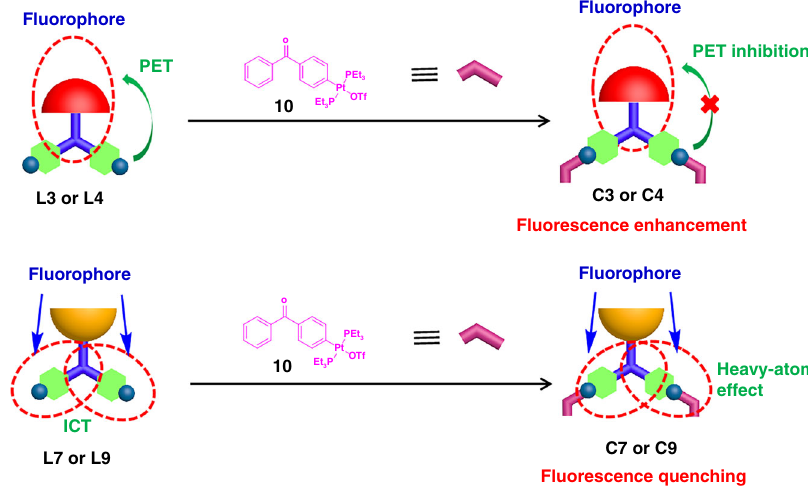
Fig. 4 Cartoon illustration of the mechanisms of fl uorescence changes of ligands L3 , L4 , L7 , and L9 responding to mono-Pt(II) ligand